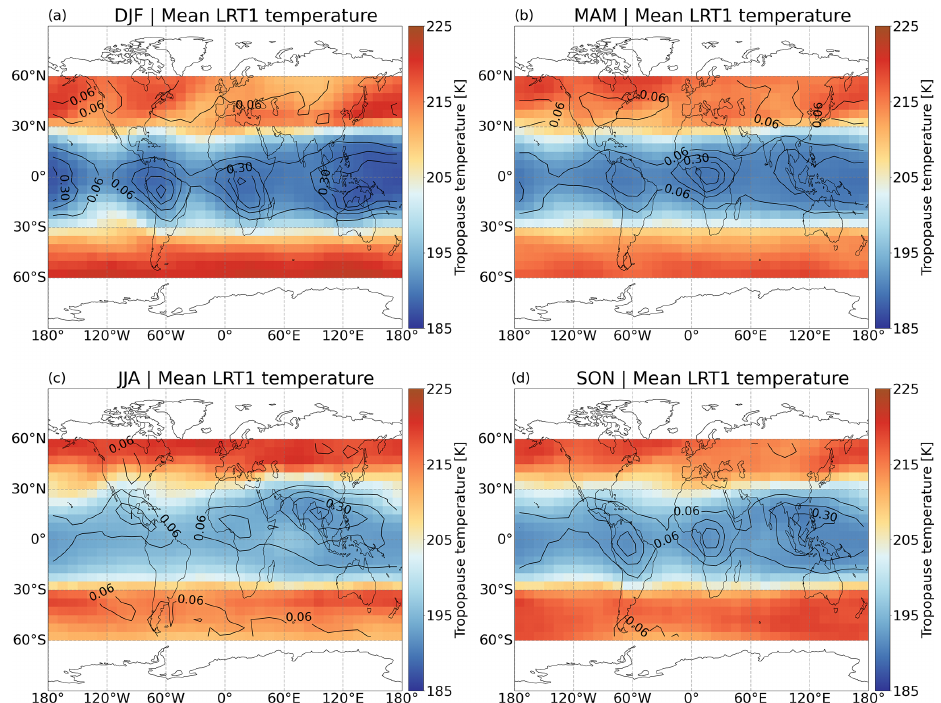
Figure 4. Seasonal mean first tropopause temperature from ERA5 (colored boxes) and occurrence frequencies of SICs from CALIPSO, as shown in Fig. 1a–d (contour lines with an interval of 0.12).